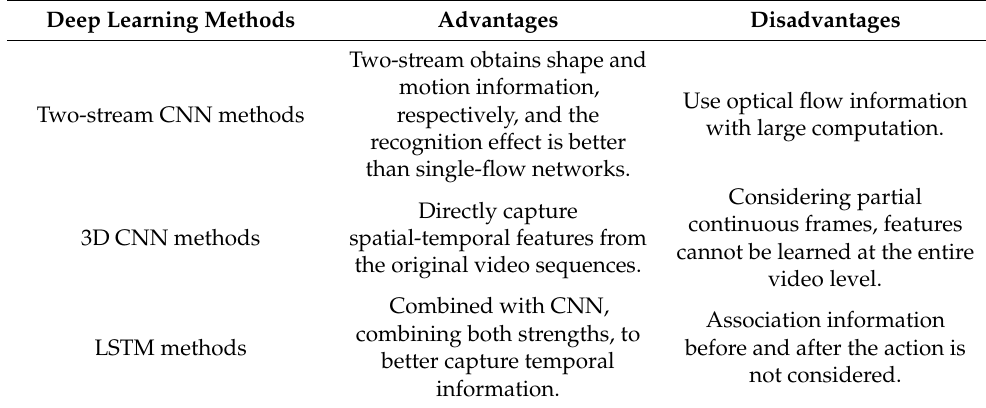
Table 1. A comparison of the three deep learning action recognition methods. Deep Learning Methods Advantages Disadvantages Two-stream obtains shape and motion information, Use optical flow information Two-stream CNN methods respectively, and the with large computation. recognition effect is better than single-flow networks. Considering partial Directly capture continuous frames, features 3D CNN methods spatial-temporal features from cannot be learned at the entire the original video sequences. video level. Combined with CNN, Association information combining both strengths, to LSTM methods before and after the action is better capture temporal not information.